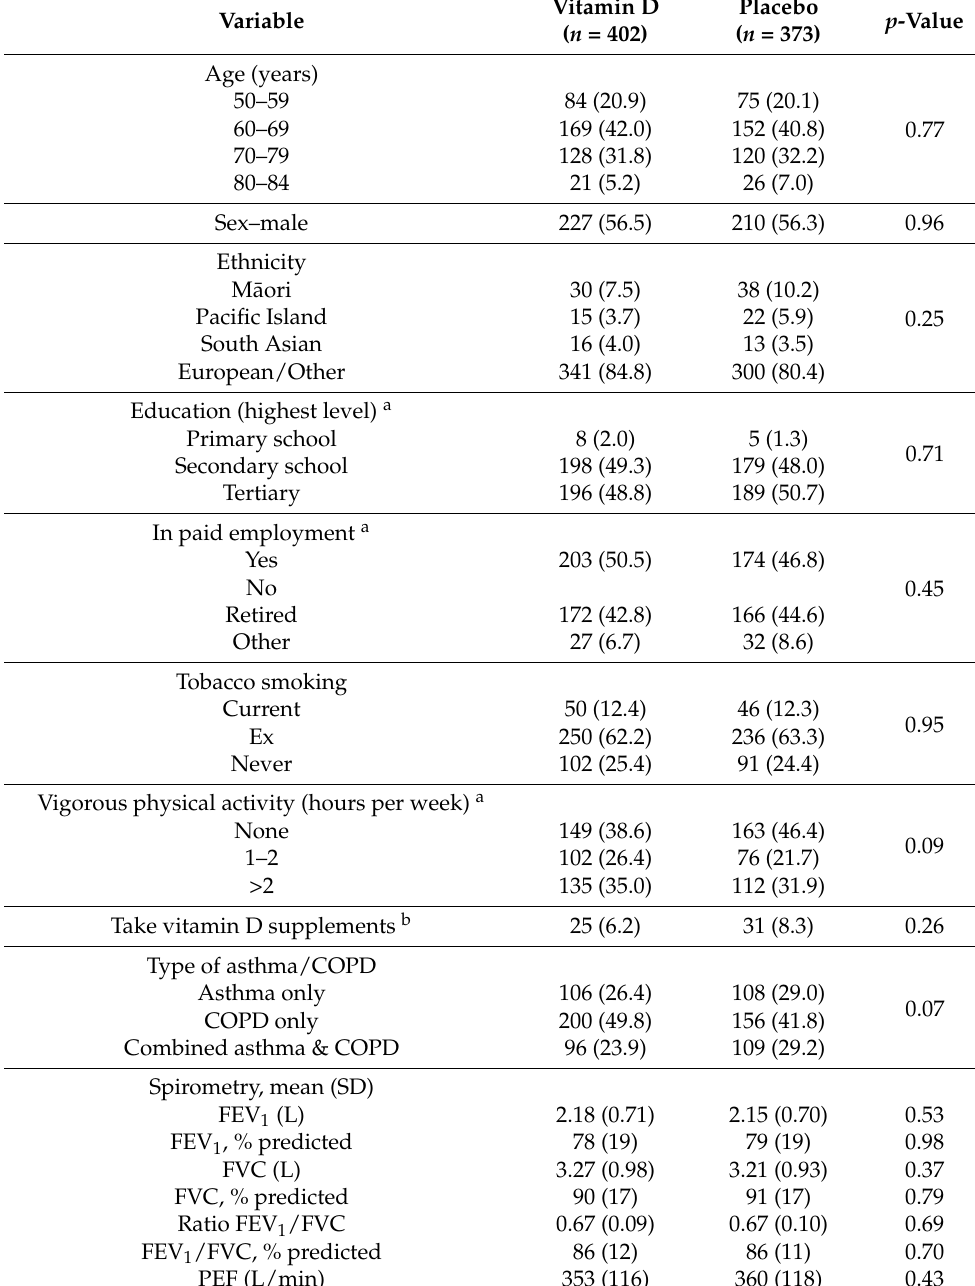
Table 1. Baseline comparison of the vitamin D supplemented and placebo